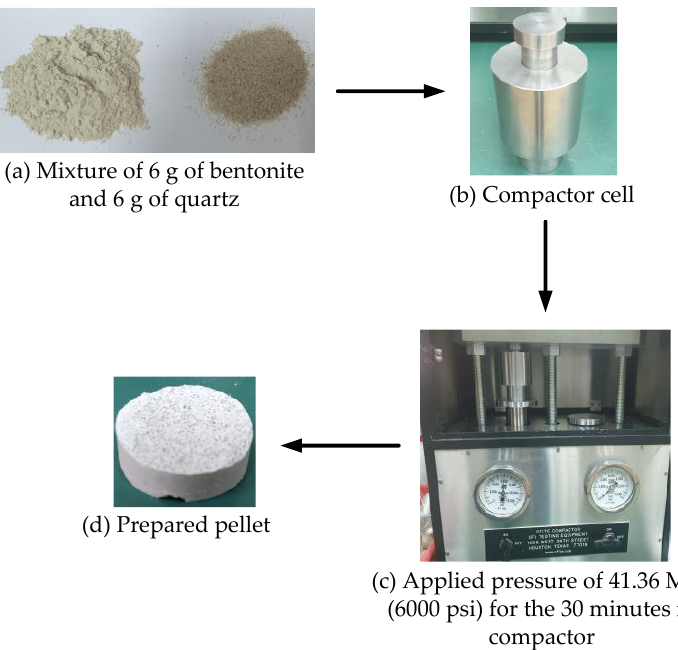
Figure 4. Preparation of quartz – bentonite pellets.